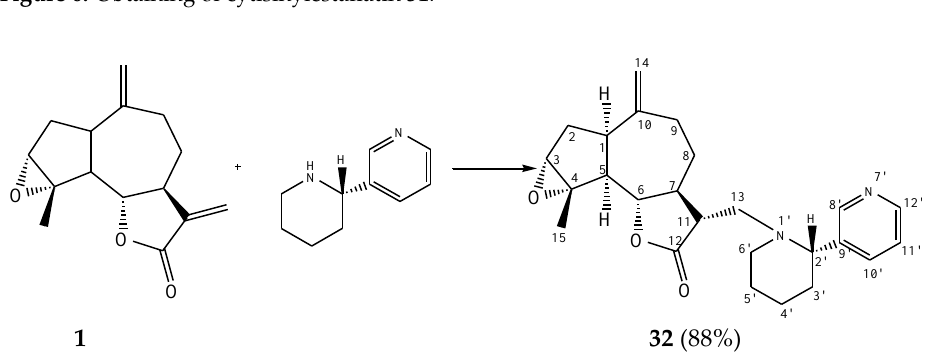
Figure 7. Obtaining of anabasinylestafiatin 32.